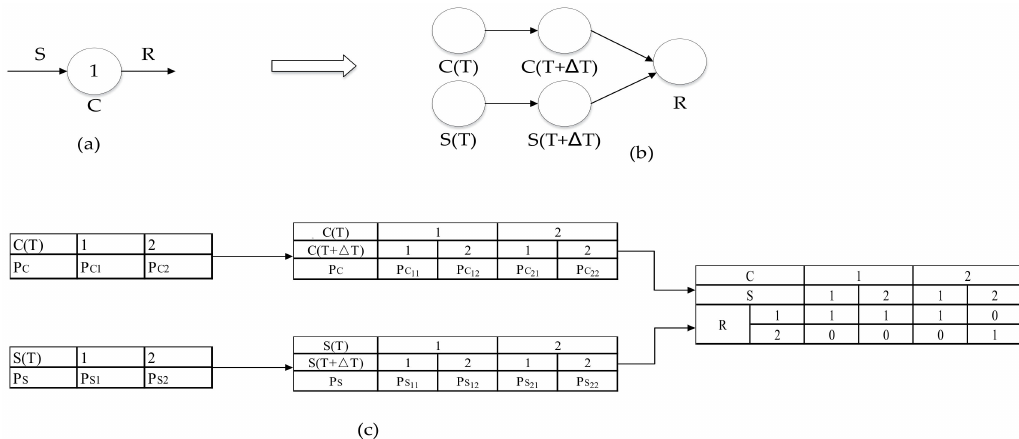
Figure 6. The dynamic Bayesian network corresponding to operator 1. ( a ) is the operator 1, ( b ) is the corresponding initial network and transition network, and ( c ) is the conditional probability table of each node.